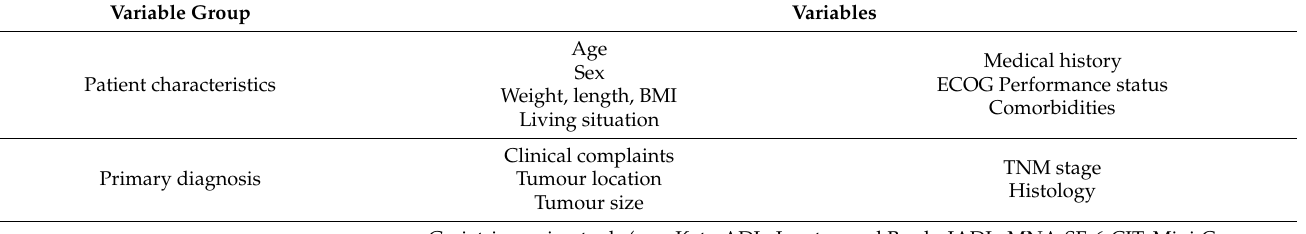
Table 2. Overview of the variables for data collection in the